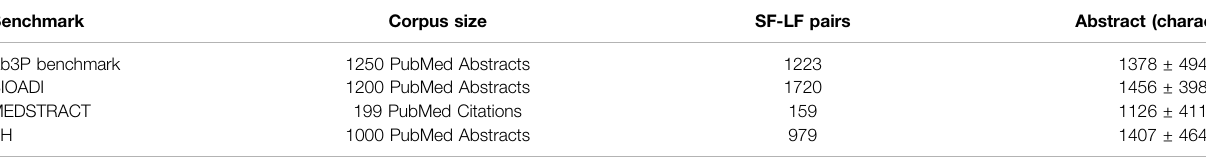
TABLE 1 | Four standard benchmarks for ADI evaluations.